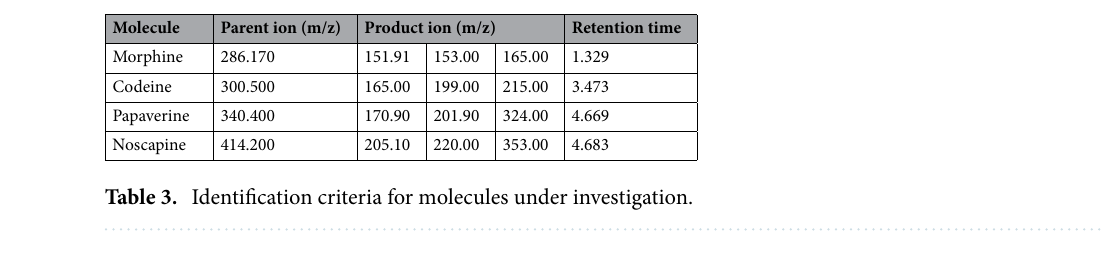
Figure 3. Radiological imaging of MI CG 21 O-US 4-1003. From ( a–h ), left lateral view of cranium. ( a ) X-rays imaging (green arrow: ante-mortem trauma). ( b ) CT image without signs of antemortem trauma. From ( c–g ), CT images of antemortem trauma probably followed by trepanation on left parietal bone. ( h ) CT image without signs of antemortem trauma. ( i ) Three-dimensional representation of cranium from superior lateral view of the left side.